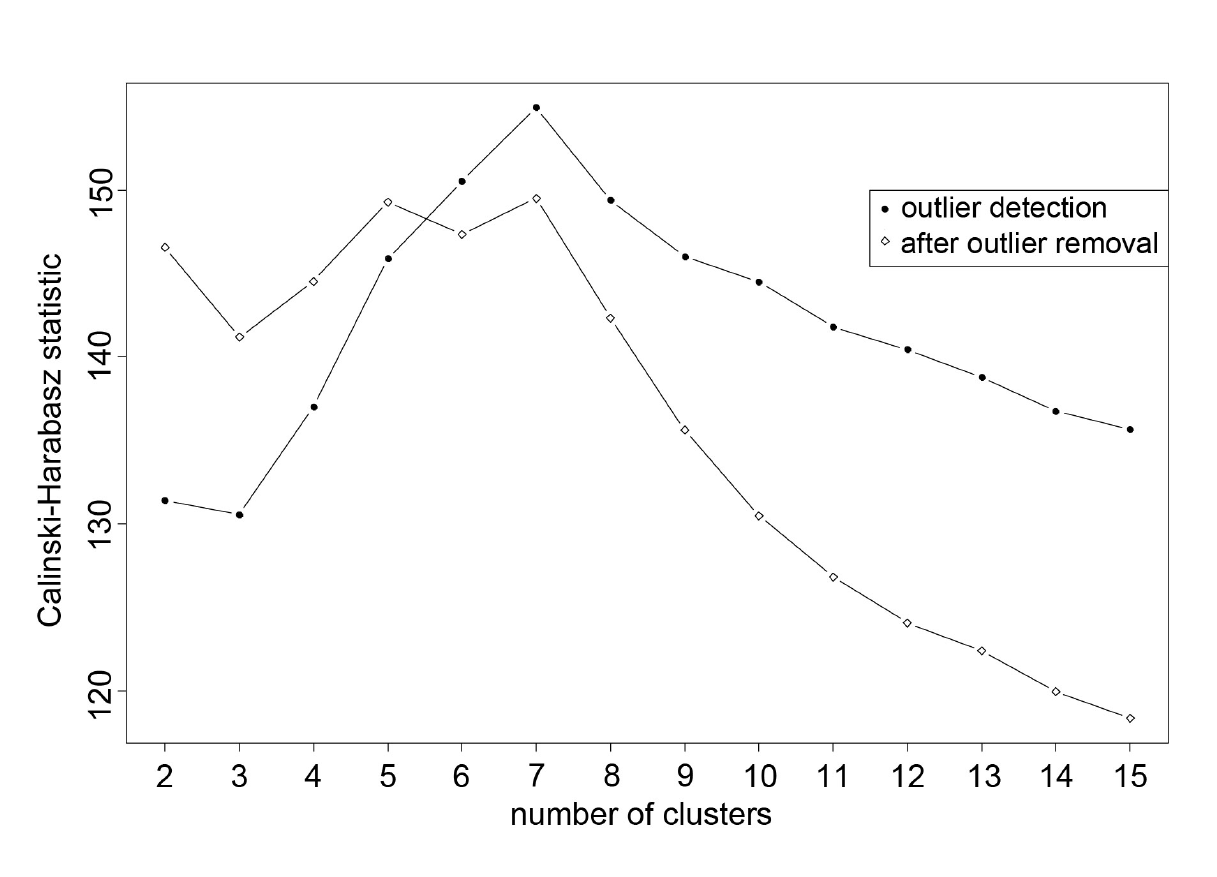
Figure 2. Calinski-Harabasz statistic in k-means clustering with 1000 random starts. First phase (line with circles): detection of outliers; second phase, after outlier removal (line with diamonds): search for optimal number of